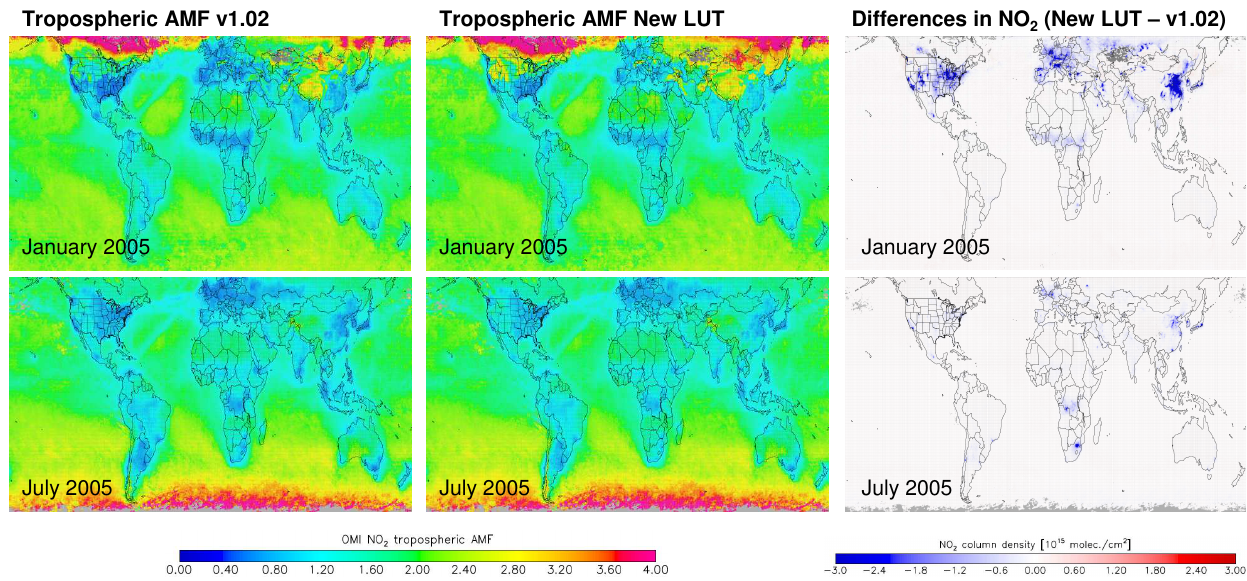
Fig. 1. Tropospheric air mass factors (AMF) calculated for v1.02 (left panels) and calculated with the new AMF lookup table (middle panels). The right panels indicate the differences between tropospheric NO 2 columns as calculated with the new AMF LUT minus tropospheric NO 2 columns calculated with the v1.02 AMF LUT. Values are monthly means for January 2005 (upper row) and July 2005 (bottom row) based on clear-sky (cloud radiance < 50%) observations).